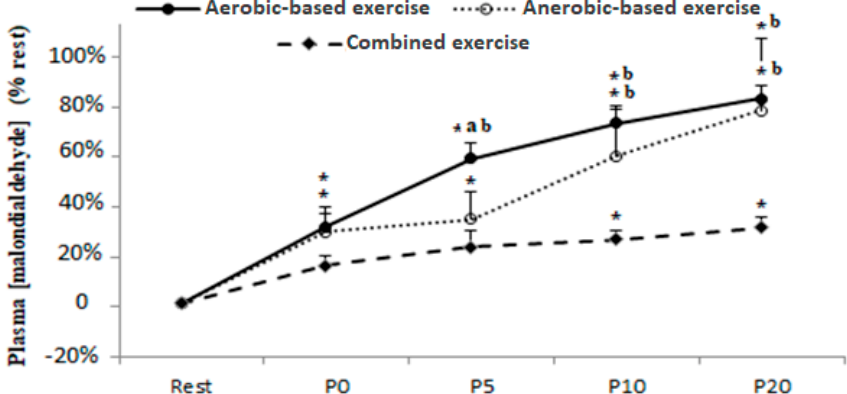
Figure 1. Plasma malondialdehyde concentration before (Rest), immediately after (P0), and 5 (P5), 10 (P10), and 20 (P20) min after aerobic, anaerobic, and combined (anaerobic and aerobic) exercise. Data are expressed as the % change from pre-exercise resting concentrations. *, **: significant di ff erence when compared to pre-test values at the level of p < 0.05 and p < 0.01 espectively; a: significant di ff erence when compared to the anaerobic exercise; b: significant di ff erence when compared to the combined (anaerobic and aerobic)